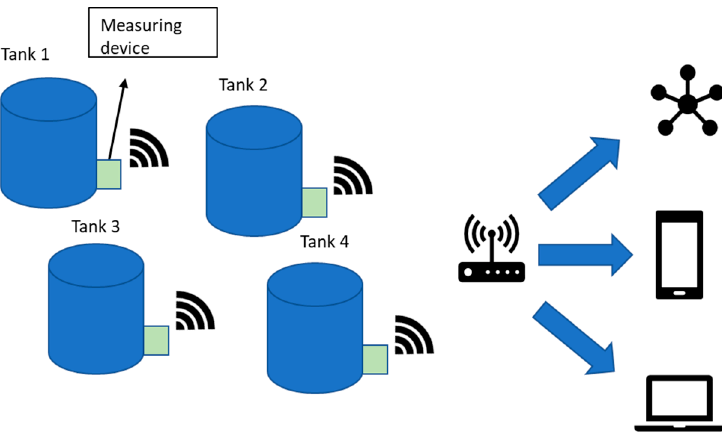
Figure 1. Conceptual scheme of the proposed system.